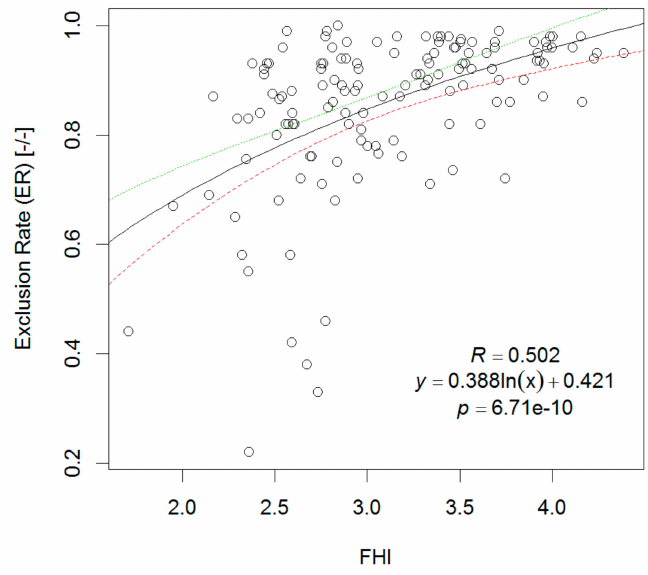
Figure 7. Exclusion rate (ER) versus farmland heterogeneity index (FHI), compared as the regional medians and means, respectively, as colored lines; the confidence interval was at level